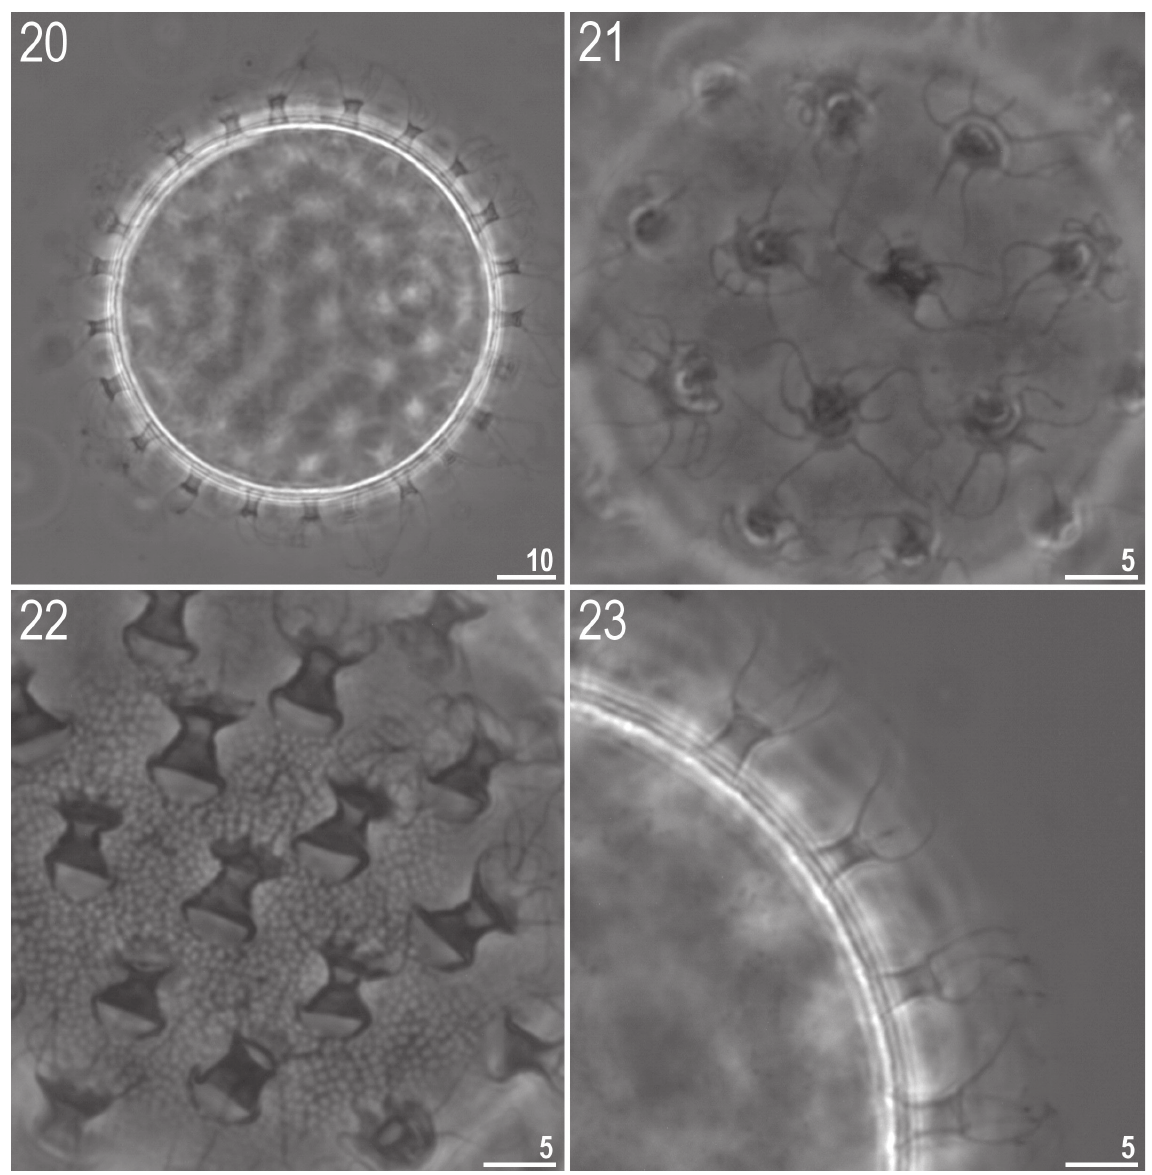
Figs 20–23. Macrobiotus polypiformis sp. nov. 20 . Chorion. 21 . Long, hair-like flexible filaments on terminal discs. 22 . Egg processes and the surface between egg processes with reticular design. 23 . Egg processes with filaments. All in PCM. Scale bars in